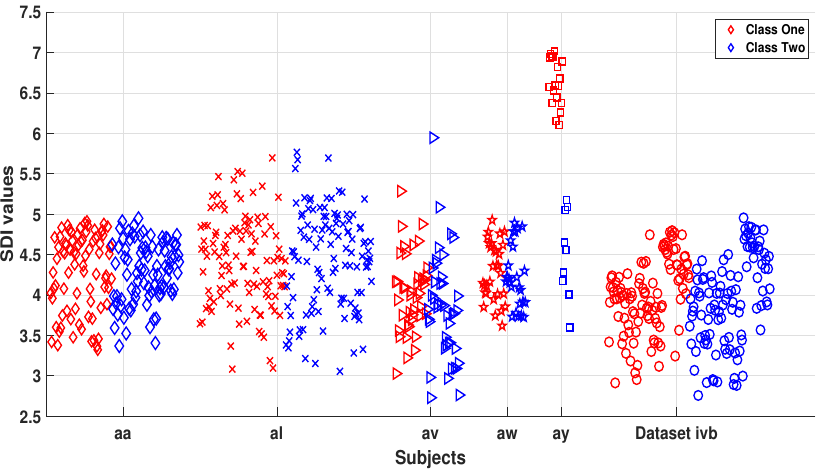
Figure 3. Scatter plot of SDI features for dataset IVa and IVb